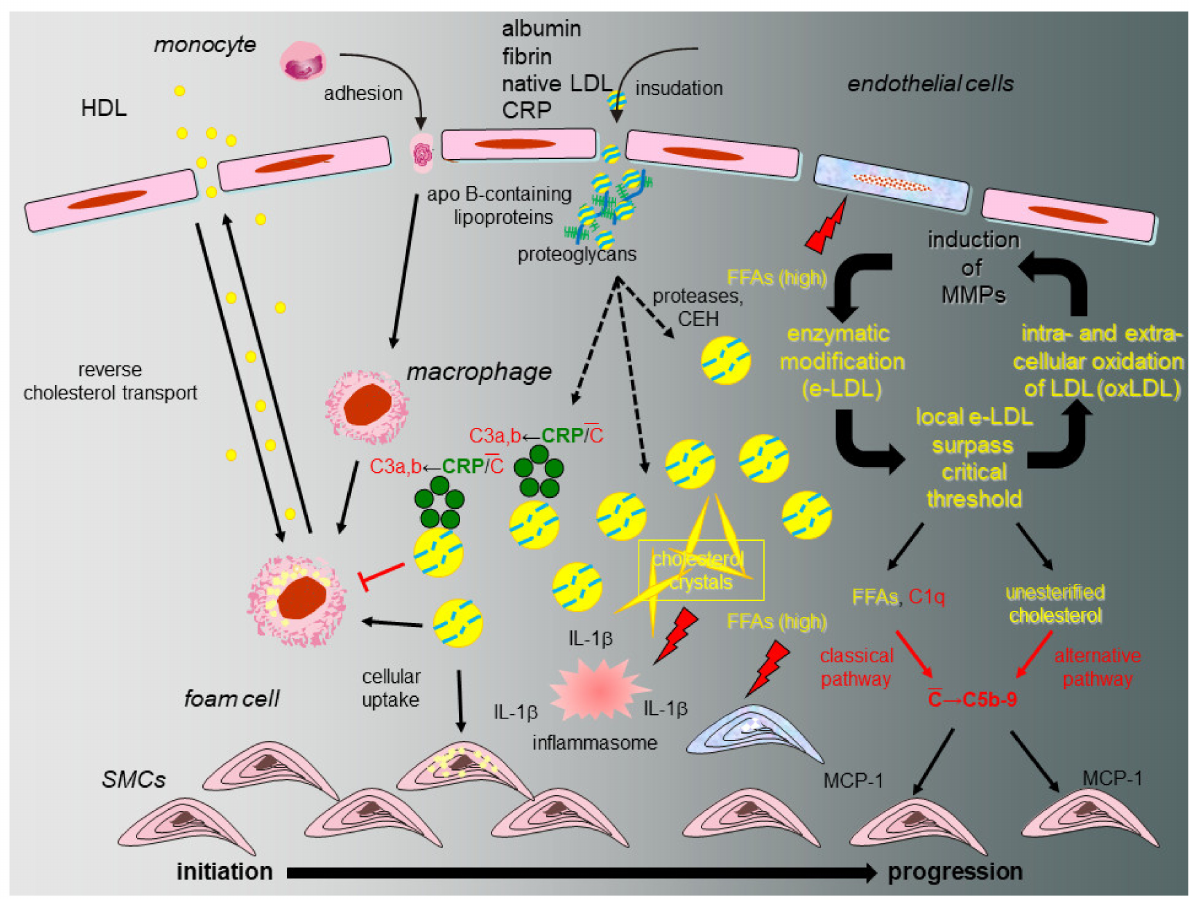
Figure 2. Proposed model of initiation and progression of atherosclerosis with special emphasis on the role of CRP and the complement system. Under normal circumstances (initiation and reversion, normocholesterolemia, left), native LDL entrapped within the arterial intima and associated with specific types of proteoglycans is enzymatically modified (eLDL), leading to a sequence of events that serve to clear the vessel wall of cholesterol. Binding of CRP to eLDL is the first trigger for complement activation (C), but in this early stage the terminal sequence is spared. The physiological sequence of events is concluded by reverse cholesterol transport. If the capacity of the system is overburdened (initiation and progression, hypercholesterolemia, right), this leads to accumulation of eLDL with subsequent generation of potentially harmful C5b-9 complexes by both the classical and alternative pathway as well as accumulation and oxidation of extracellular LDL particles followed by a wealth of well-documented events like MMP production in surrounding cells and subsequent amplification of enzymatic degradation of LDL. Hydrolysis of the core cholesteryl esters and subsequent cholesterol crystallization mediates formation of the inflammasome directly stimulating NLRP3 leading to increased tissue levels of IL-1 β . FFAs play multifaceted roles through their dual capacity to exert stimulatory and cytotoxic effects on neighboring cells (modified from